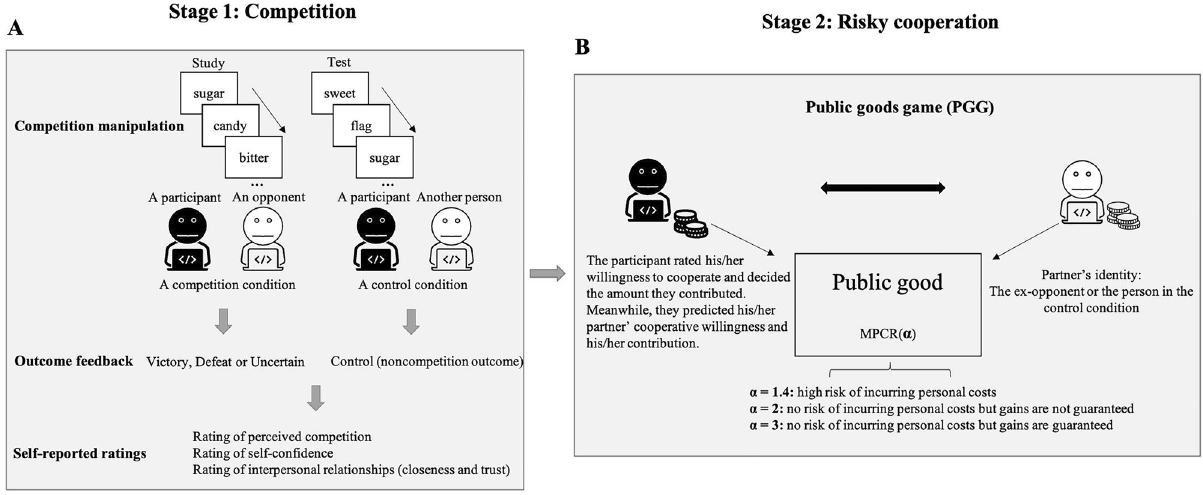
Figure 1. Experimental task structure. ( A ) The competition with outcome feedback manipulation is represented. In a between-participants design, participants were randomly assigned to receive one of four types of outcome feedback (victory vs. defeat vs. uncertain competitive outcome vs. no competition (control)). We used a standard version of the Deese–Roediger–McDermott (DRM) paradigm as the competitive task. At the end of the competition, participants were immediately given information about their performance. Specifically, they received one of three types of outcome feedback (victory vs. defeat vs. uncertain competitive outcome). After receiving outcome feedback, participants were asked to provide a rating on a nine-point Likert scale of their perceived competition (the intensity they felt about the competition) (1 = not at all, 9 = extremely), self- confidence (1 = not at all confident, 9 = completely confident), the degree of closeness that they felt toward their opponents (1 = not at all close, 9 = completely close) and the level of trust that they felt toward their opponents (1 = no trust at all, 9 = complete trust). ( B ) After completing the competition stage, participants played a modified version of a two-person public goods game (PGG). Participants were asked to indicate their own willingness to cooperate as well as their predictions about their opponents’ willingness to cooperate on a 9-point rating scale (1 = not at all to 9 = very willing). Meanwhile, participants had to decide how many tokens they wished to contribute to the public good and also predict how many tokens their opponents would contribute. MPCR, marginal per-capita